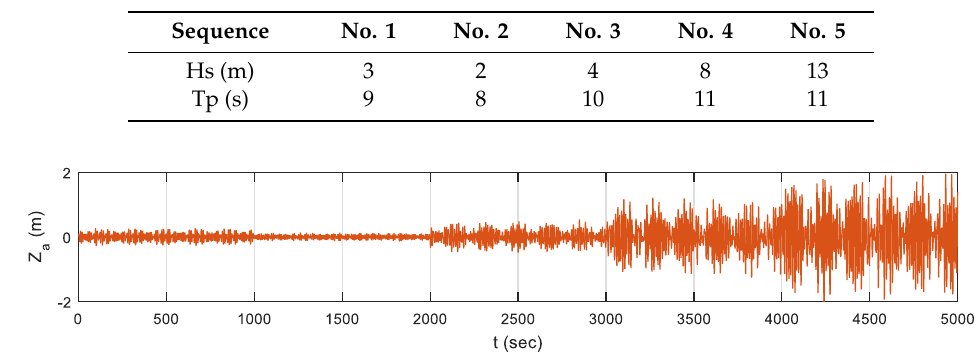
Figure 33. Time series of heave motion during sea state change.